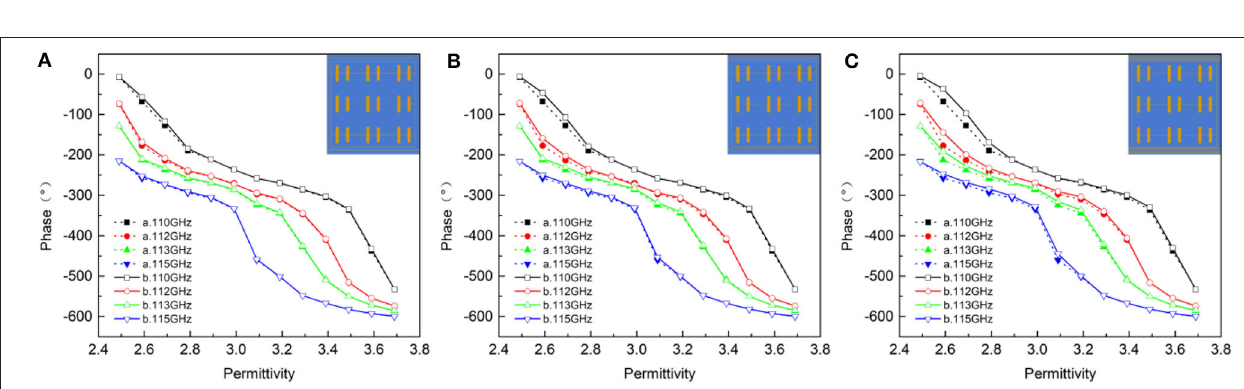
FIGURE 4 | Comparisons of phase-shift performances for different bias line arrangements. Two trunk bias lines (A) . Three trunk bias lines (B) . Five trunk bias lines (C) .